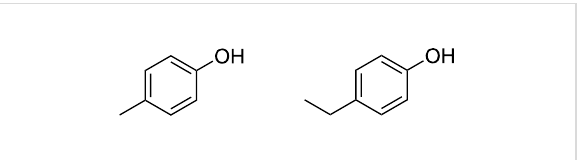
Figure 8: Structures of para -methylphenol and para -ethylphenol. Para- substituted phenols have been shown to trigger gel formation in AOT w/o systems [94,104]